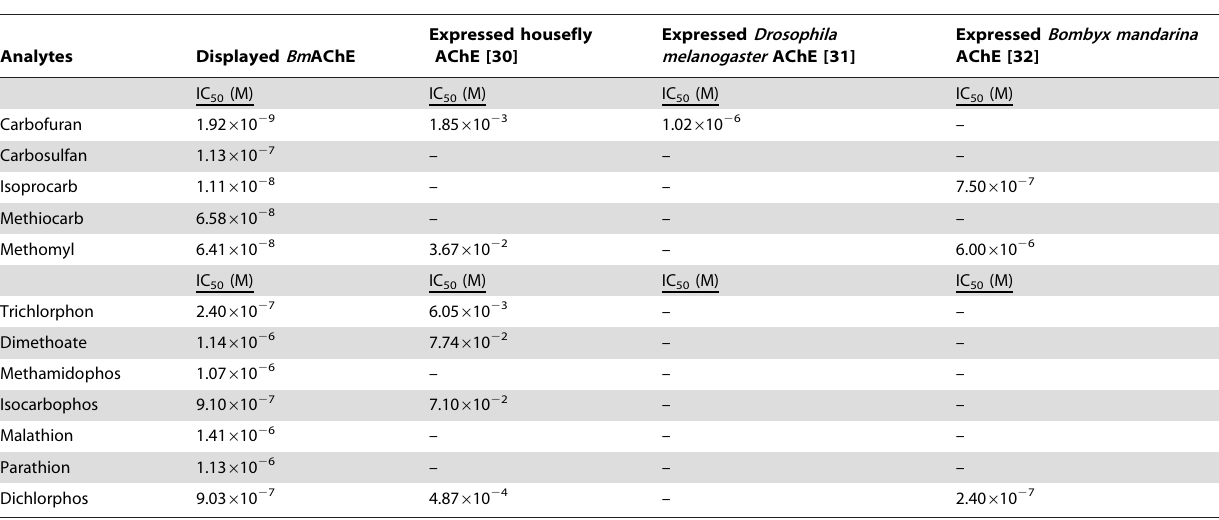
Table 2. The median inhibition concentration (IC 50 ) of displayed Bm AChE for five CB and seven OP